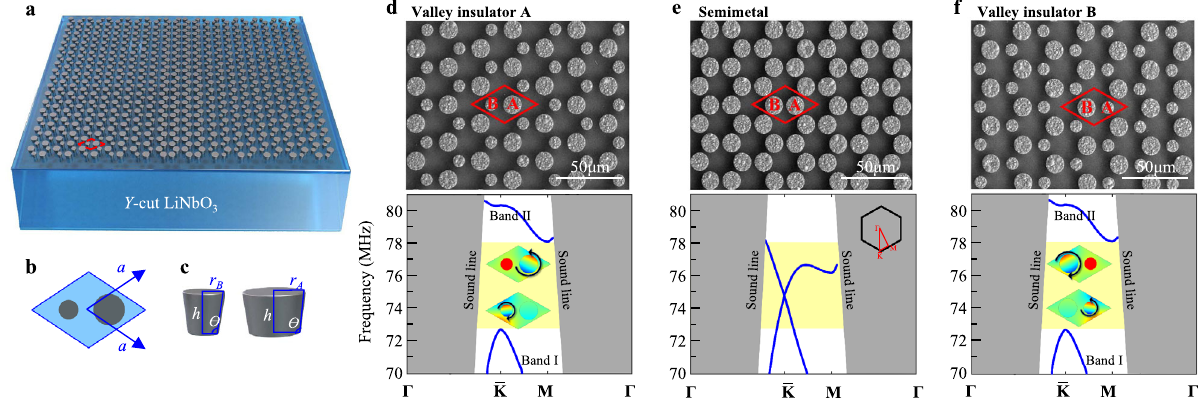
Fig. 1 Our on-chip phononic crystals for SAWs. a Schematic of our phononic crystals containing two sets of micro-resonator pillars, marked as A and B, on ffiffiffi p μ m. c schematic of two inequitable pillars. d – f a y -cut LiNbO 3 semi-in fi nite half-space. b Unit cell of our phononic crystal, its lattice constant a = 42 = 3 (upper) SEM images and (bottom) calculated band structures of three different phononic crystals with different topological phases. e A SAW Dirac “ semimetal ” with the same A and B pillars ( r = r = 5.8 μ m). d and f Two SAW valley “ insulators ” with inequivalent A/B pillars in their radius, both having A B omnidirectional bandgaps at their (cid:1) K and (cid:1) K ’ points of the 1st Brillouin zones, i.e., the valleys. We call the “ insulator ” in d ( r A = 5.9 μ m r B = 3.9 μ m) as valley insulator A (VA) and the “ insulator ” in f ( r A = 3.9 μ m r B = 5.9 μ m) as valley insulator B (VB). Insets show the SAW fl ux vortices observed at their